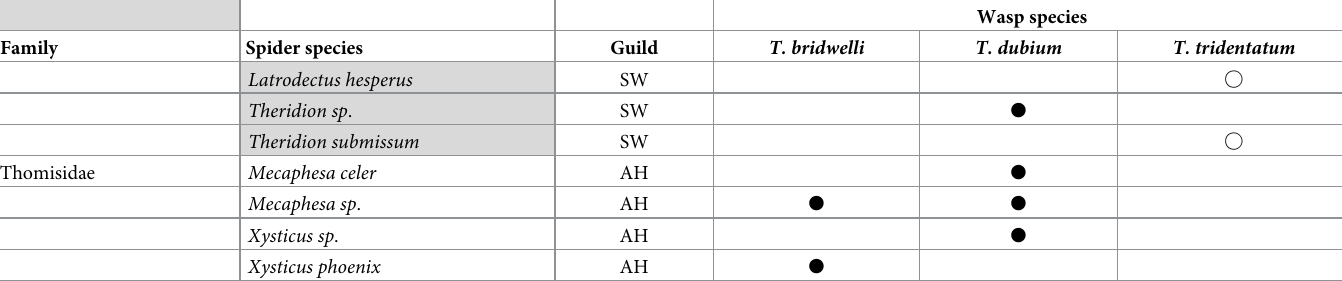
(Table 2). Globally, a total of 45 spider species were preyed upon in oases and seven spider spe- cies in the desert. The occurrence of spider species varied between the wasp species, but the most common spiders included Sassacus , Eustala and Metepeira (Fig 2). Phidippus phoenix Edwards (Salticidae) was the unique spider prey captured by the three wasp species. Individu- als of the family Salticidae were the most recurrent in the nests (38.3%), followed by Araneidae (33.2%) and Theridiidae (17.3%). Sassacus vitis Cockerell (Salticidae) (27.2%), M. arizonica (Araneidae) (22.8%), and Theridion submissum Gertsch & Davis (Theridiidae) (16.6%) were the most frequent species in the nests. Only Trypoxylon bridwelli captured two different species of ant-mimic jumping spiders ( Peckhamia spp.), while only T. dubium and T. tridentatum included nocturnal spiders in the diet (Table 2). The abundance of spiders in the diet varied accordingly to the stage of development during the life cycle (H = 33.8, d.f. = 2, p < 0.001 ). The vast majority were in juvenile stages (69%) (Fig 3A). The peak of prey abundance occurred in July (i.e. 43.6%) (Fig 3B). However, neither the habitat (GLMM, χ 2 = 2.56, p = 0.11) nor the month of the year were predictors of the length 1 of brood cells ( χ 2 = 7.46, p = 0.18) and nest length ( χ 2 = 2.64, p = 0.75) (Fig 3C and 3D). The 5 5 temporal pattern of abundance across the time was the same either for males (H = 2.2, d.f. = 3, p = 0.531), females (H = 1.6, d.f. = 3, p = 0.657) and juvenile spiders (H = 2.22, d.f. = 3, p = 0.527). Among the six spider guilds, the group of stalkers was the most abundant (43.8%) and had the highest richness (42.3%) within the nests (Fig 4A). The number of spider species per guild varied among wasps ( χ 2 = 20.6, p = 0.024). None of the wasp species included all spider 10 guilds in their diet. Trypoxylon bridwelli consumed mostly stalkers (68.4%), T. tridentatum mainly orb weavers (40.9%), and T. dubium was less selective, combining prey from stalkers (38%) and space web guilds (28.5%) (Fig 4B). The bipartite interactions between prey and predators showed a high degree of both overall specialization (H ´ = 0.89) and diversity of interactions (H´ = 2.6). Our network significantly 2 differed from expected null models (Mean ± S.D.: 0.09 ± 0.01, p < 0.001) (Fig 5). The community structure of spider prey was significantly different between the mud-daub- ing wasps (PERMANOVA F = 2.63, d.f. = 2, p = 0.001), and the variability in community struc- ture (i.e. spider composition) was different between all of the wasp species (PERMDISP: F = 4.19, d.f. = 2, p = 0.02 ) (Fig 6). The spider prey diversity (H´) was significantly different between the three wasp species and the accumulation curves of prey diversity was asymptotic in T. dubium (Fig 7). Trypoxylon tridentatum showed the richest composition of prey and nocturnal species, whilst T. dubium showed the highest values of diversity, evenness and niche breadth. Moreover, T. bridwelli